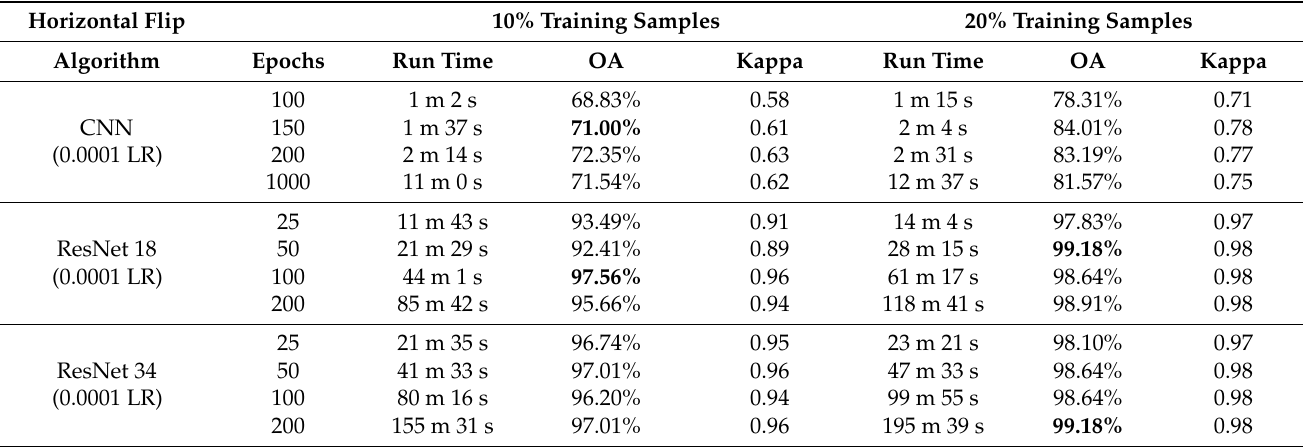
Table 6. Comparison of overall accuracy, Kappa statistic, and run time for CNN, ResNet 18, and ResNet 34 with four different epoch sizes, two different training sizes with horizontal flip image